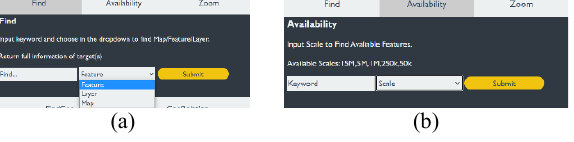
Figure 5 . Panel of functions. (a) Find (b) Availability.